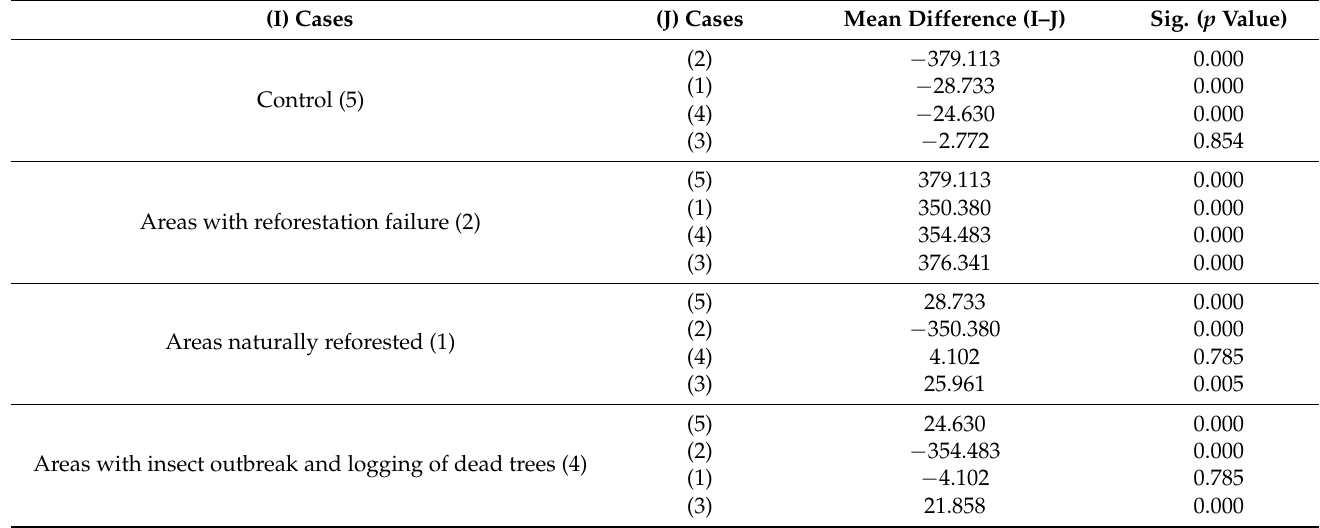
Table 3. Pairwise comparisons among the cases, mean differences, and significance